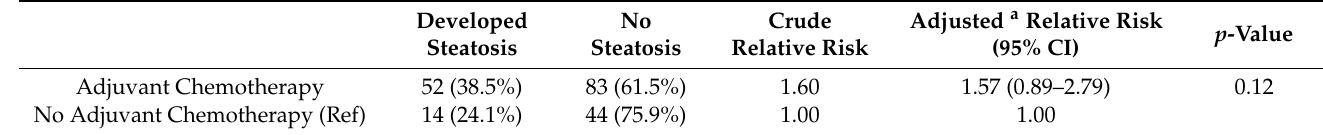
Table 2. Association between adjuvant chemotherapy exposure and outcome of steatosis in patients with colorectal